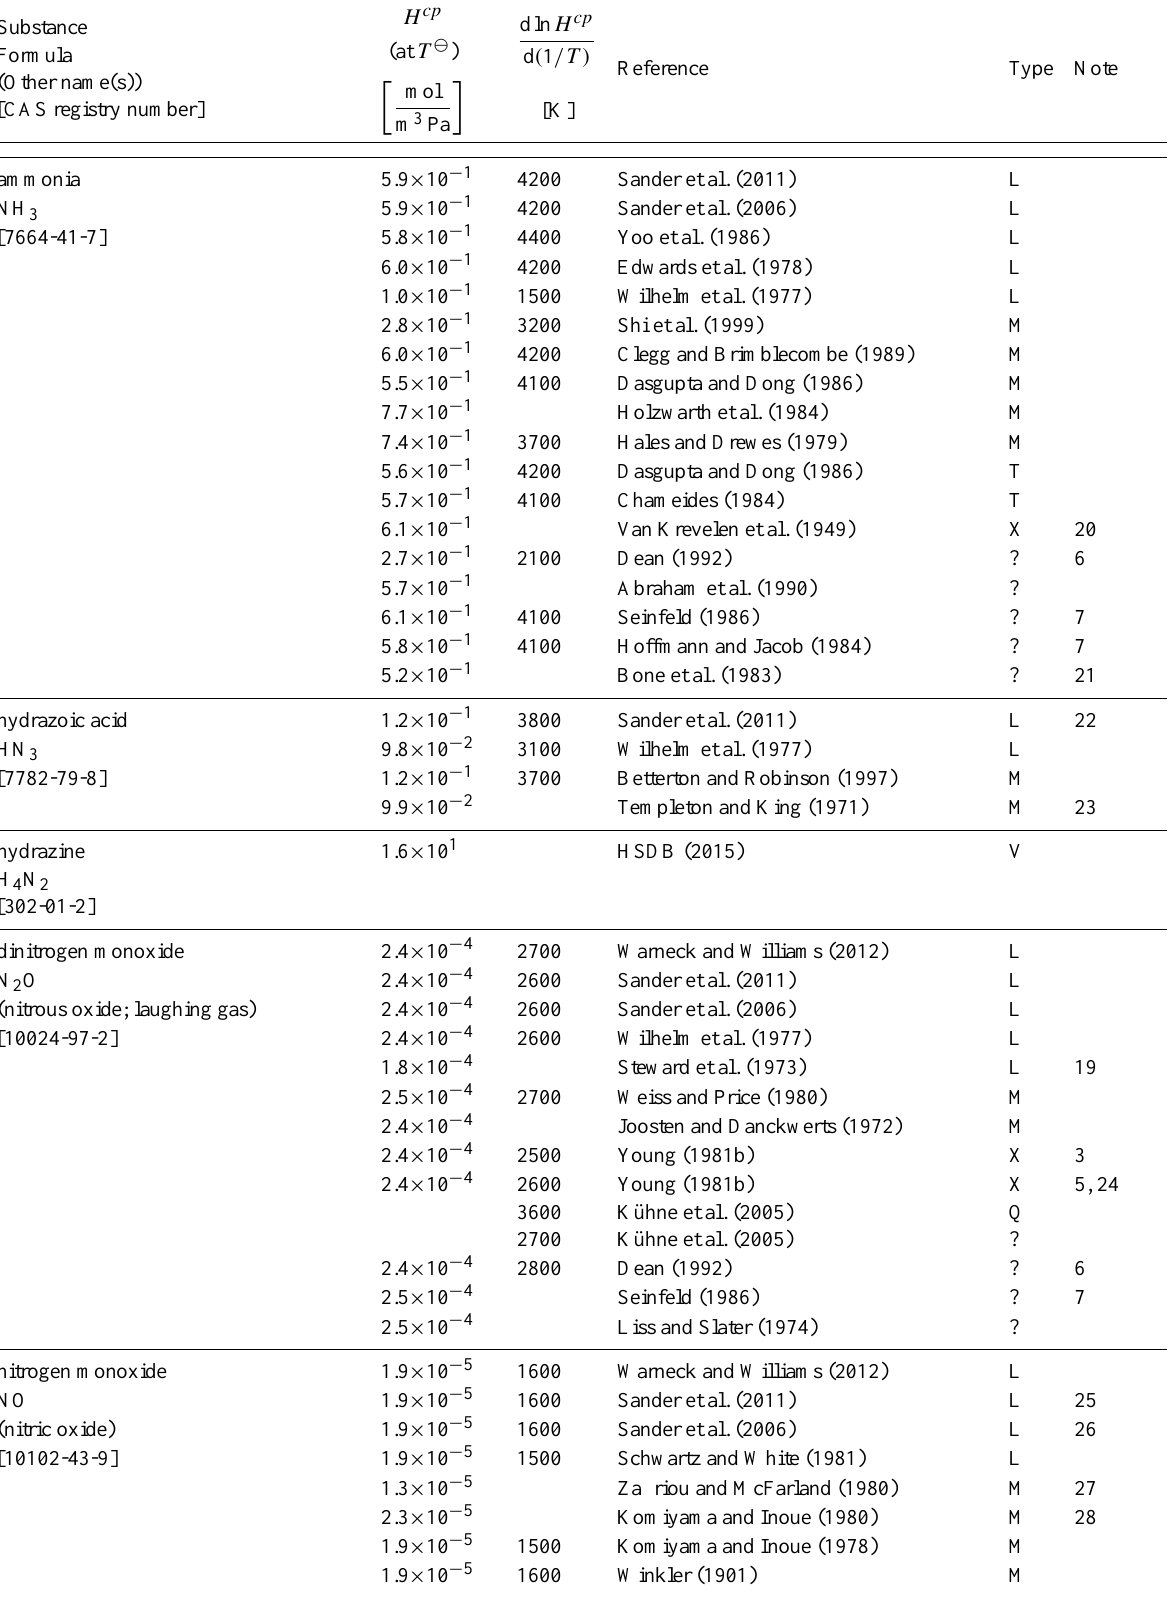
Table 6: Henry’s law constants for water as solvent